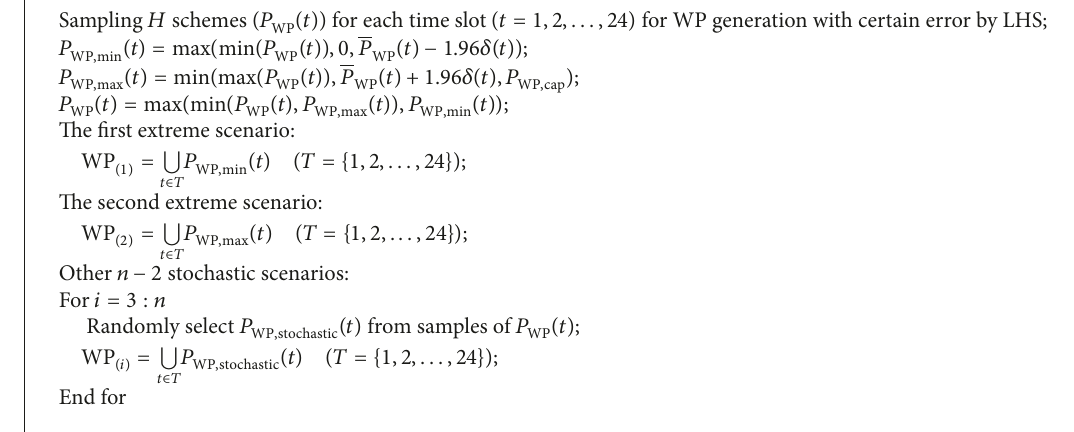
Algorithm 1: 24-hour WP scenarios